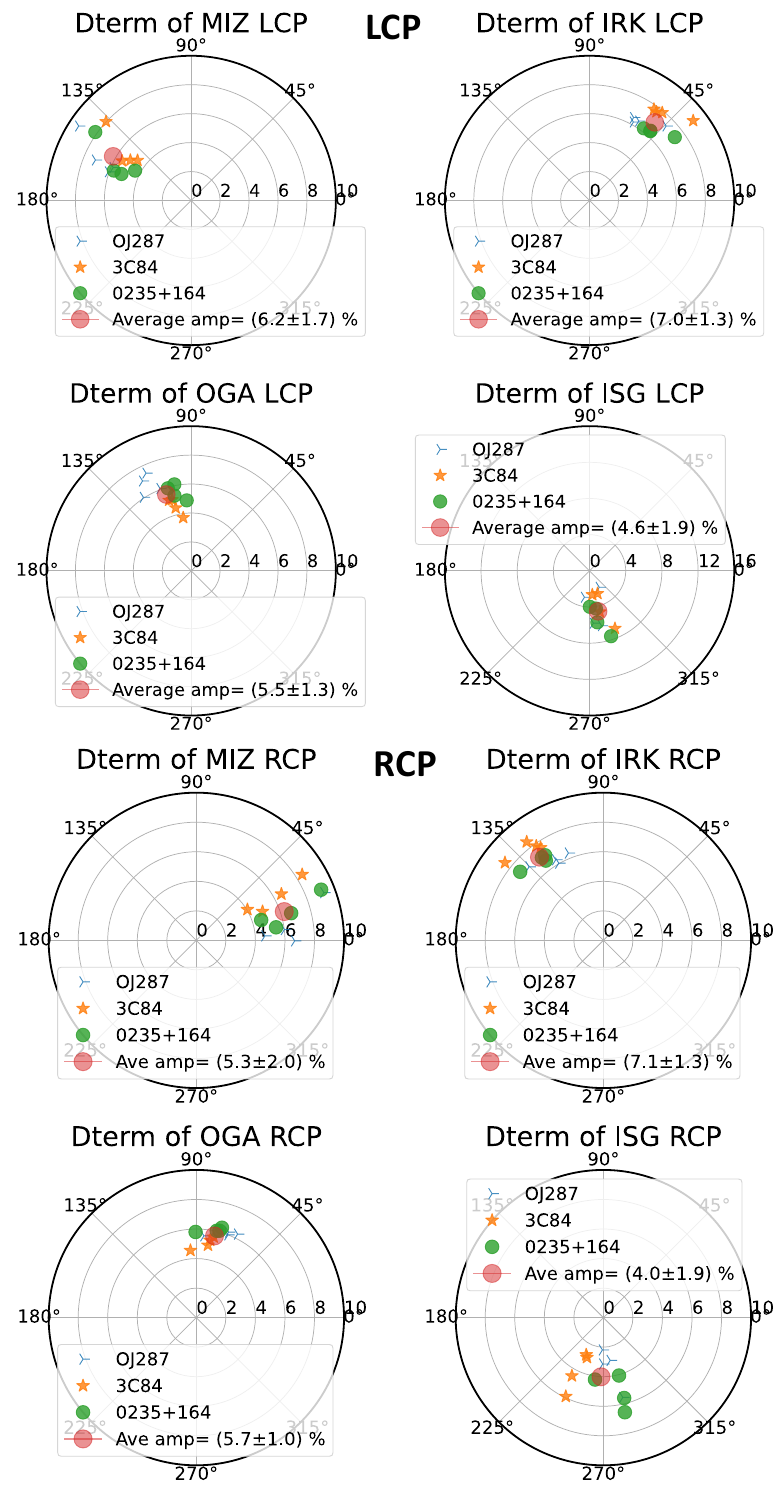
Figure 5. D-terms obtained using different calibrator sources (different colors) at 22 GHz observations by combining all four IF sub-bands. Each panel shows D-terms of each of the four VERA 20 m telescopes at each circular polarization ( upper : LCP, lower : RCP). D-terms obtained by averaging over the sources are also shown. The radius of each plot is in